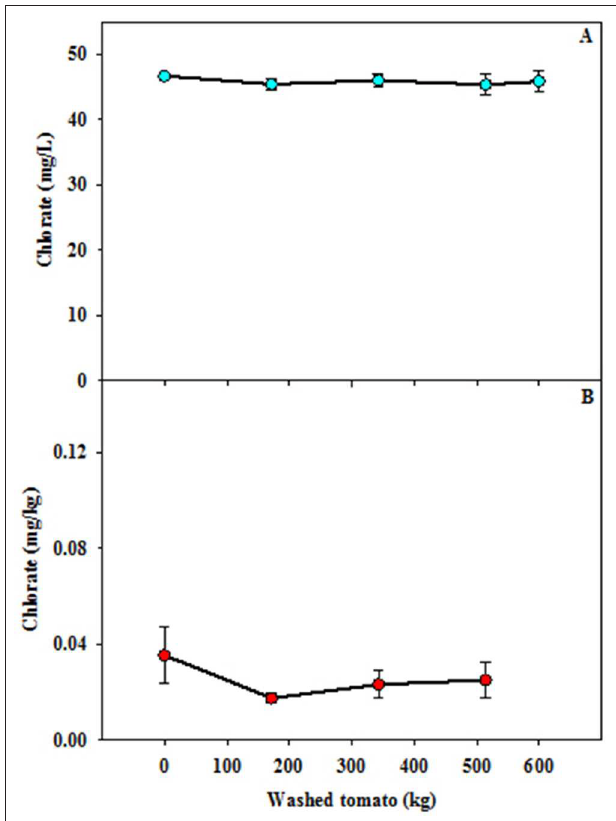
FIGURE 4 | Concentration of chlorate in (A) ClO 2 -treated recirculated water (3rd test) and (B) tomato washed in ClO 2 -treated water (3rd